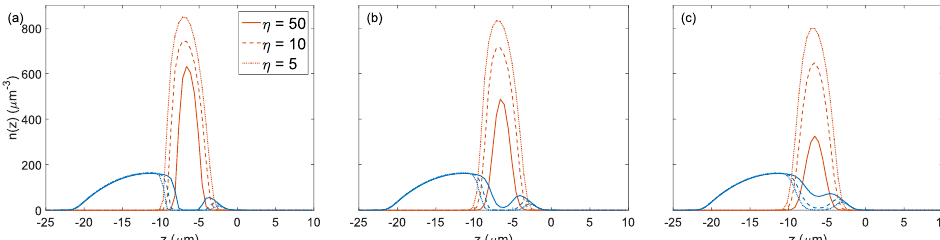
Figure 2. Density profiles along the z -axis of the simulated ground-state of 23 Na (in blue) and 39 K (in red): ( a ) B = 100 G with δ = 4.32, ( b ) B = 108 G with δ = 0.22 and ( c ) B = 111 G with δ = − 0.50. In each case, we display the results of three atom number ratio η = N Na / N K equal to 50 (solid lines), 10 (dashed lines) and 5 (dotted